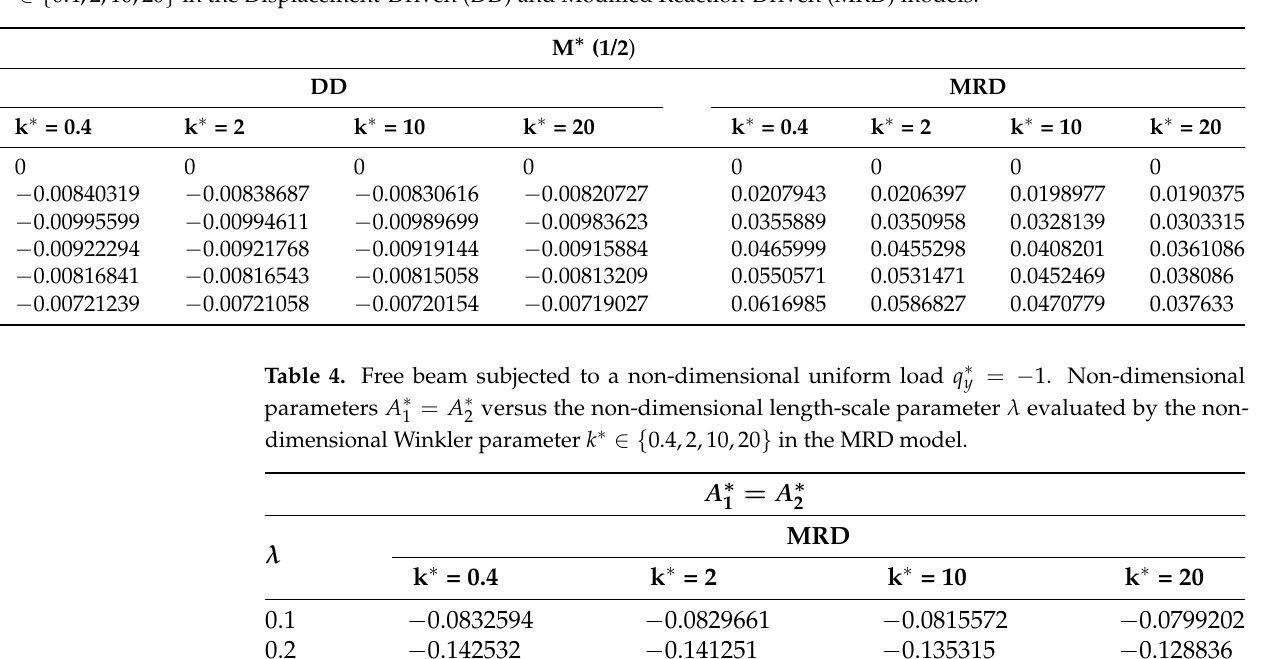
Table 3. Free beam subjected to a non-dimensional uniform load q ∗ y = − 1. Non-dimensional midpoint bending moment M ∗ ( 1/2 ) versus the non-dimensional length-scale parameter λ evaluated by the non-dimensional Winkler parameter k ∗ ∈ { 0.4,2,10,20 } in the Displacement-Driven (DD) and Modified Reaction-Driven (MRD) models.